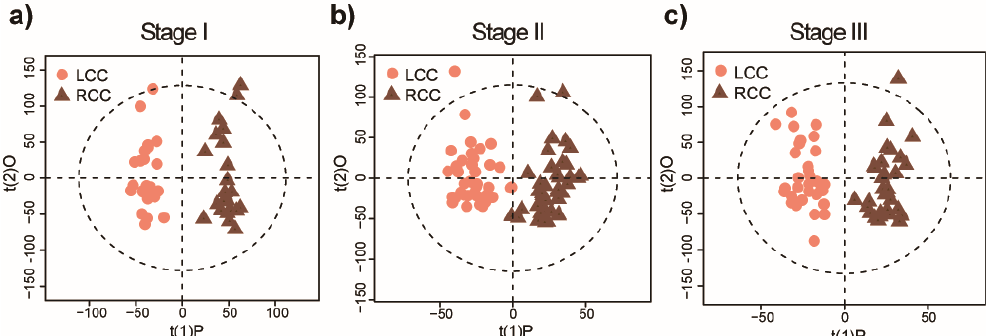
Figure 2. Distinct metabolomic fingerprints of left-sided colon cancer (LCC) and right-sided colon cancer (RCC). The supervised OPLS-DA plots for metabolic fingerprints of ( a ) stage I LCCs ( n = 25) and stage I RCCs ( n = 22) ( b ) stage II LCCs ( n = 42) and stage II RCCs ( n = 44), and ( c ) stage III LCCs ( n = 32) and stage III RCCs ( n = 32). Dotted circle in the plot indicates the 95% confidence interval.